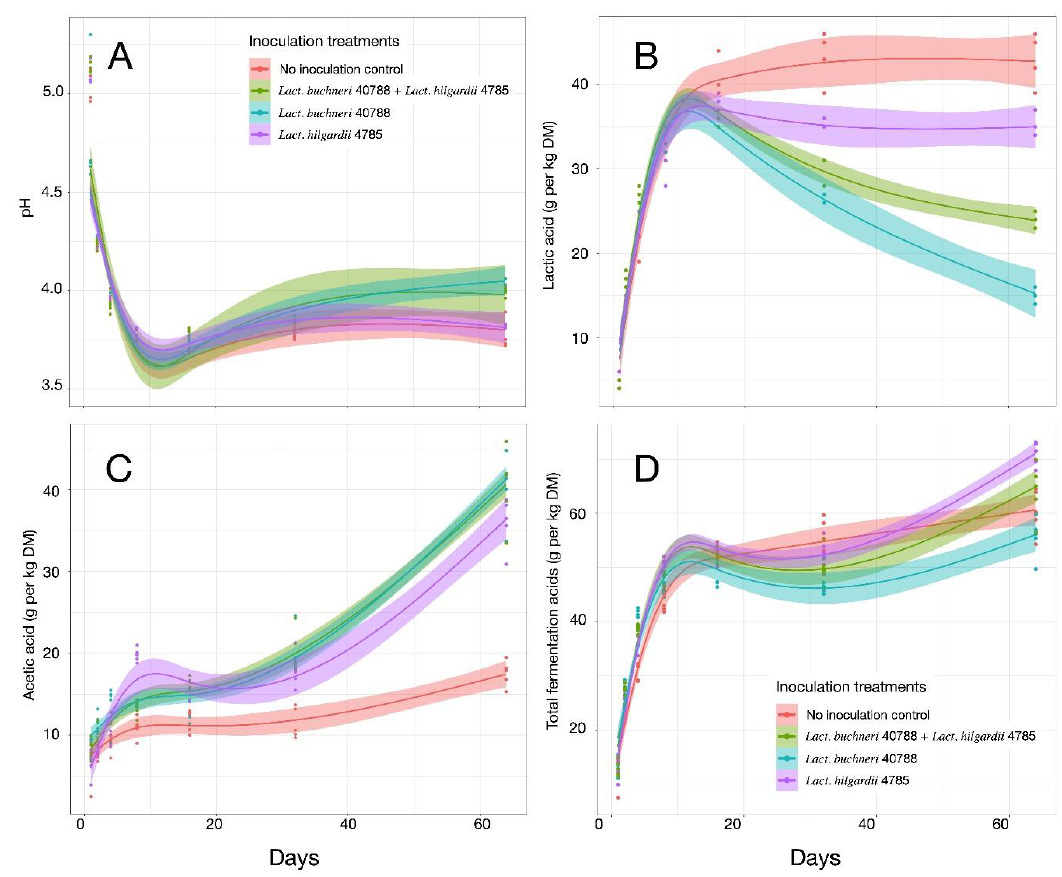
Figure 6. Fermentation kinetics of independent samples of corn silages harvested after 1, 2, 4, 8, 16, 32, and 64 days of fermentation. The following four inoculation treatments were applied: Control, Lb. buchneri , Lb. hilgardii , and a combination of the two LAB species. The four panels show pH ( A ), the concentration of lactic acid ( B ), the concentration of acetic acid ( C ), and the concentration of total volatile fatty acids ( D ). The trend lines correspond to a smoothing function computed by linear modelling using the y~ns(x,3) equation. The shaded area boarding each trend line represents the 95% confidence interval. Table 1. Results of the mixed effect model analysis for comparison of the fermentation profiles at all opening periods between the control and the bacterial inoculation treatments.